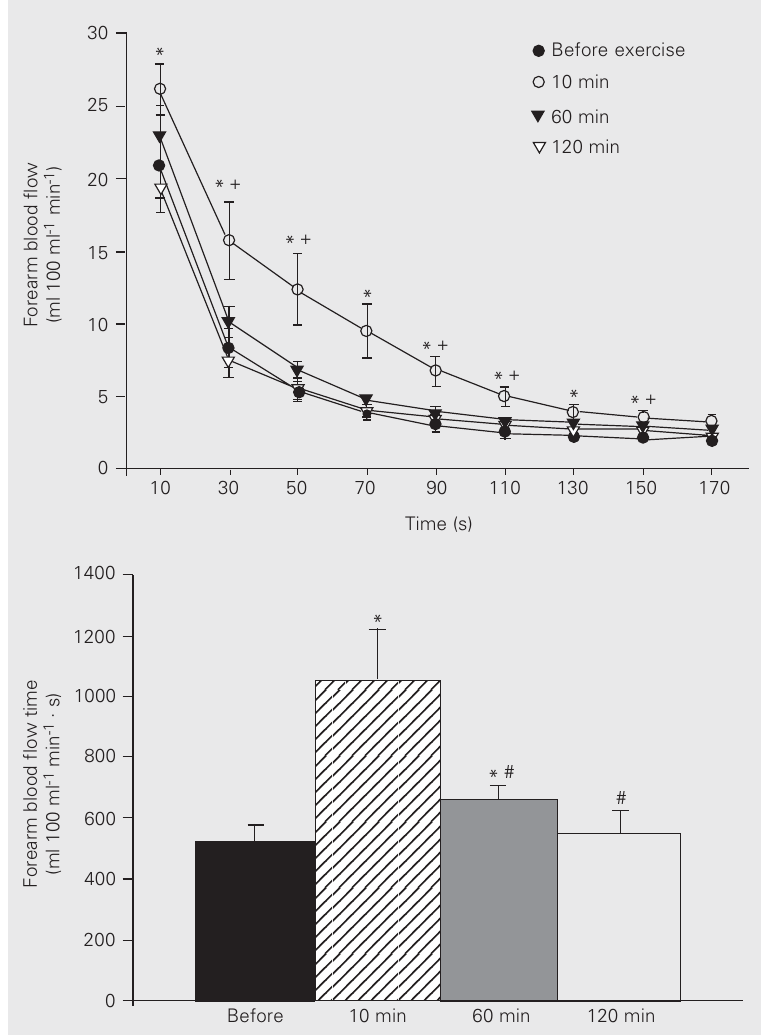
Figure 2. Temporal response and total excess blood flow during reactive hyperemia. Forearm blood flow increased during reactive hyperemia at 10 min and 60 min after the exercise test compared to before exercise (upper panel). Total excess flow (blood flow during reactive hyperemia minus baseline flow; lower panel), an indicator of vascular reactivity, was in- creased up to 1 h after cessation of exercise. *P < 0.05 for 10 min vs before exercise; + P < 0.05 for 60 min vs before exercise; # P < 0.05 vs 10 min (ANOVA for repeated measures with the post hoc Bonferroni